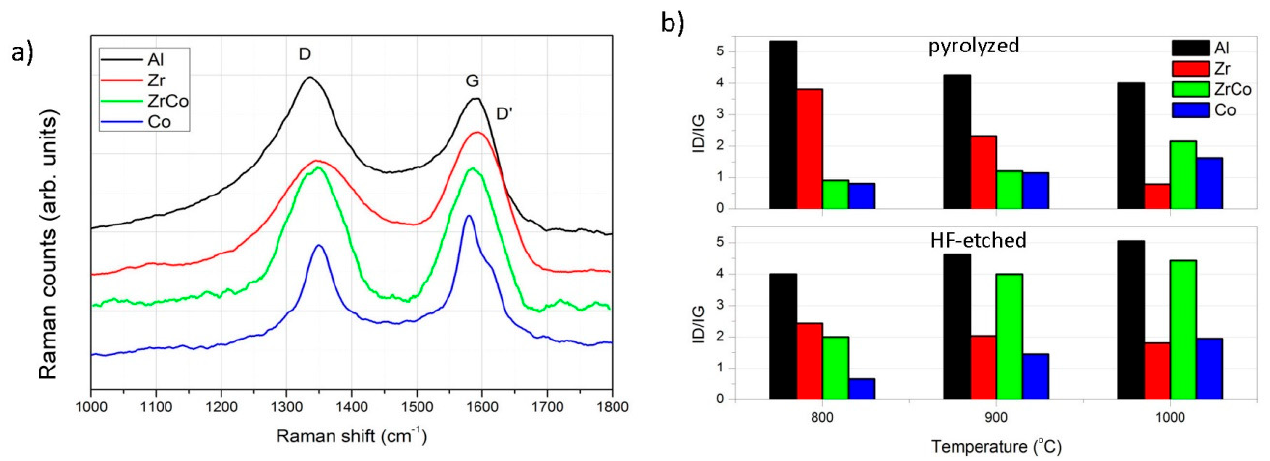
Figure 4. ( a ) Raman spectra of the samples pyrolyzed at 900 ◦ C; ( b ) relative intensity of the D and G bands (ID/IG) of the Raman spectra of the pyrolyzed and HF-etched